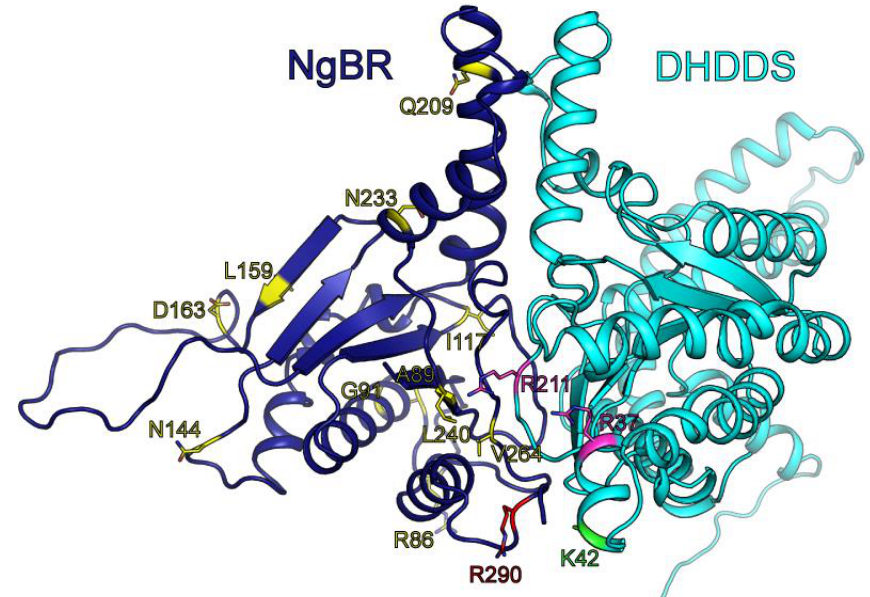
Figure 7. A model for the heterodimeric cis -prenyltransferase complex. The model of the heterodimeric complex is shown in cartoon representation. DHDDS and NgBR are colored cyan and blue, respectively. Positions with disease-associated mutations are shown as sticks and colored as follows: K42, related to retinitis pigmentosa, green; R37 and R211, related to developmental epileptic encephalopathies, magenta; R290, related to a congenital glycosylation disorder, red; R86, A89, G91, I117, N144, L159, D163, Q209, N233, L240 and V264, related to Parkinson’s disease, yellow. Finally, the DHDDS mutations known to result in autosomal recessive retinitis pigmentosa [9,10] and developmental epileptic encephalopathies [12], and NgBR mutations associated with